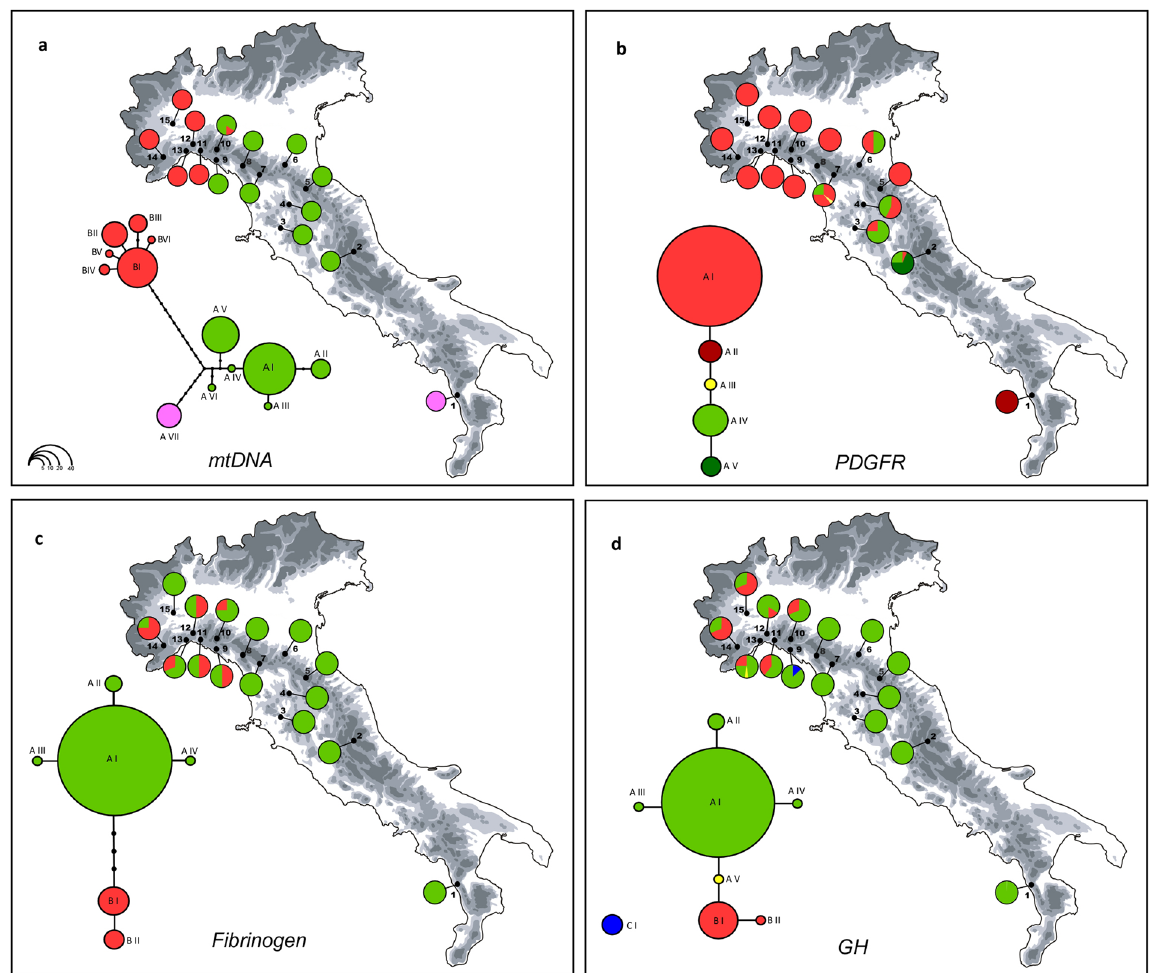
Figure 3. Haplotype genealogy based on a maximum likelihood phylogenetic tree of the Ichthyosaura alpestris mtDNA haplotypes found ( a ). Statistical parsimony network showing genealogical relationships among haplotypes in PDGFR ( b ), β - FIB ( c ) and GH ( d ) genes. Circle sizes are proportional to haplotype frequency; missing intermediate haplotypes are shown as black dots. Pie diagrams show the frequency distributions of the haplogroups among the populations studied. The map was drawn using the software Canvas 11 (ACD Systems of America, Inc.).